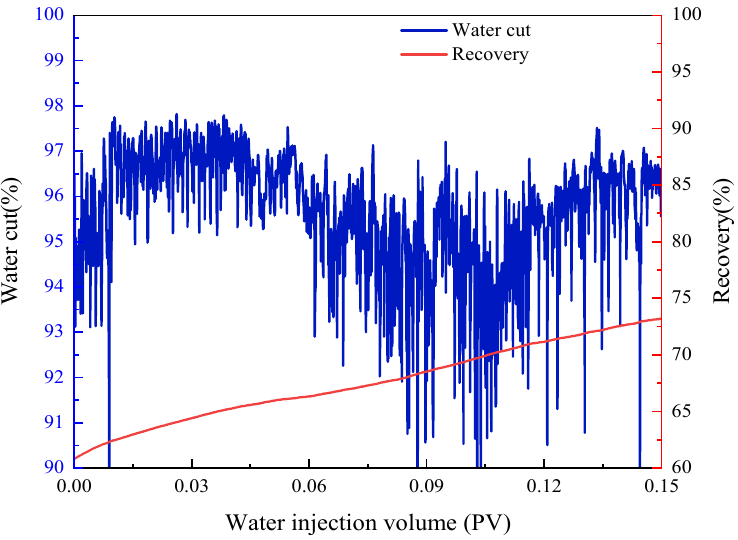
Figure 8. Production curves of artificial water injection stage.